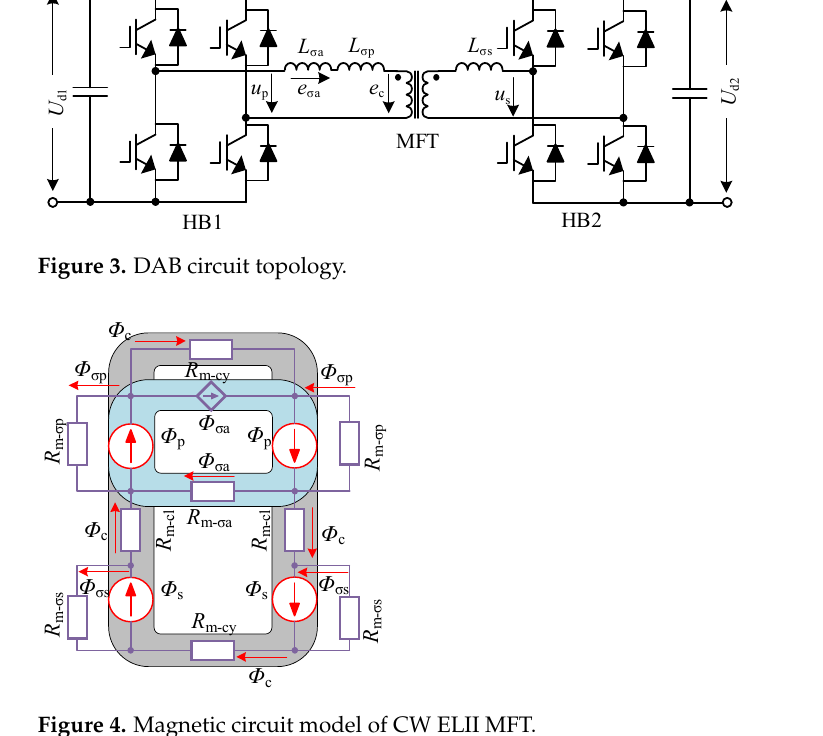
Figure 4. Magnetic circuit model of CW ELII MFT.